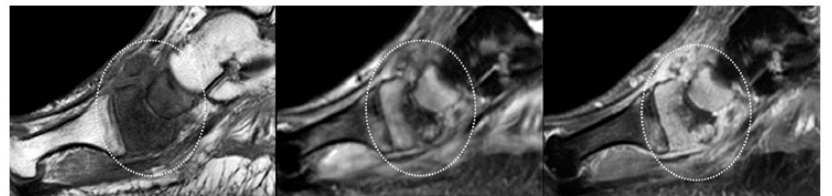
Figure 2. OM of the scaphoid and medial cuneiform. (From left to right) Sagittal T1-weighted, T2-fat-suppressed, and post-contrast T1-weighted fat-suppressed MRI clearly show that the marrow in the scaphoid and medial cuneiform has a low signal on a T1-weighted image (circle in left panel), increased signal on a fluid-sensitive fat-suppressed image (circle in middle panel), and post-gadolinium enhancement (circle in panel). These findings are indicative of OM. Several secondary features such as subtending skin ulcer, sinus tract, abscess, tenosynovitis, or septic arthritis tend to be associated with OM. Their presence strongly suggests that osteomyelitis is